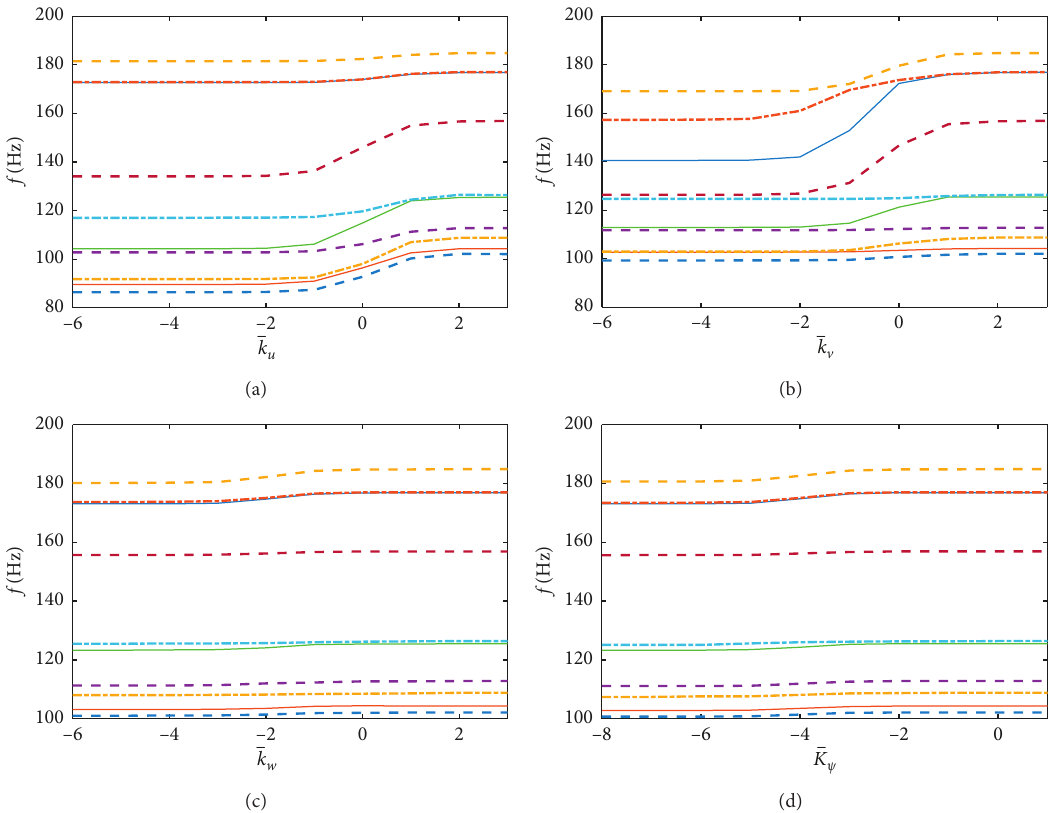
Figure 11: Frequency curves of the first 10 orders of conical shell with one displacement elastically restrained and the others